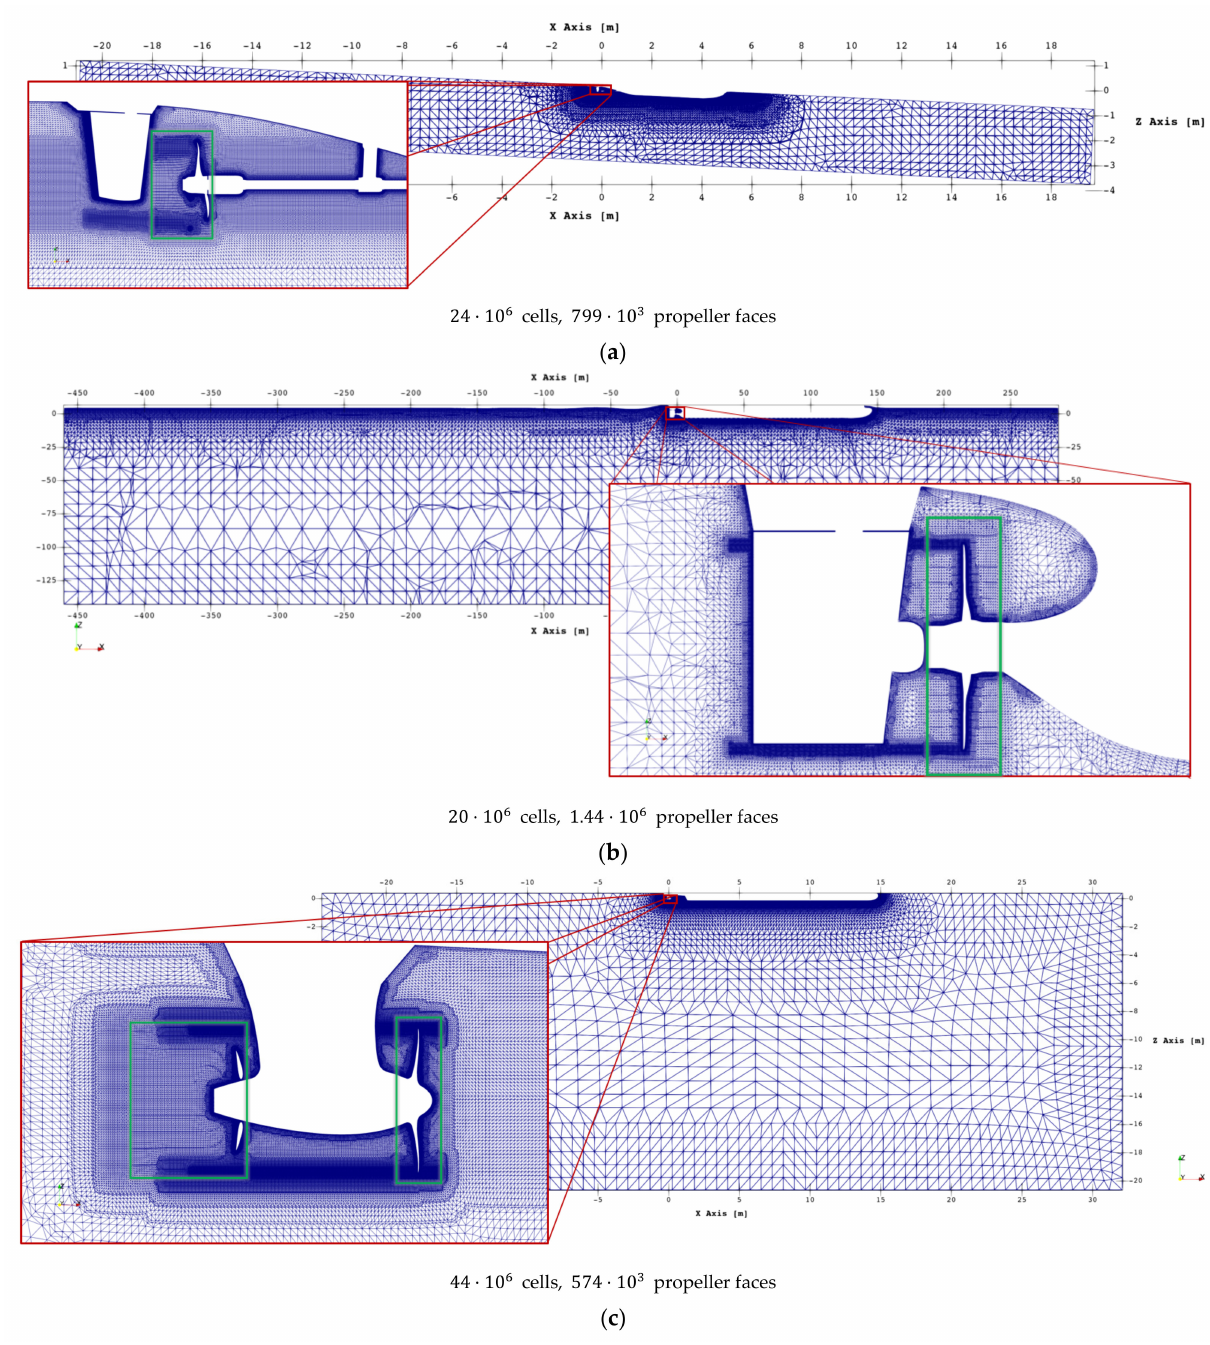
Figure 3. Behind ship mesh: ( a ) ProNoVi Target Case; ( b ) SCHOTTEL Reference Case 1; ( c ) SCHOTTEL Reference Case